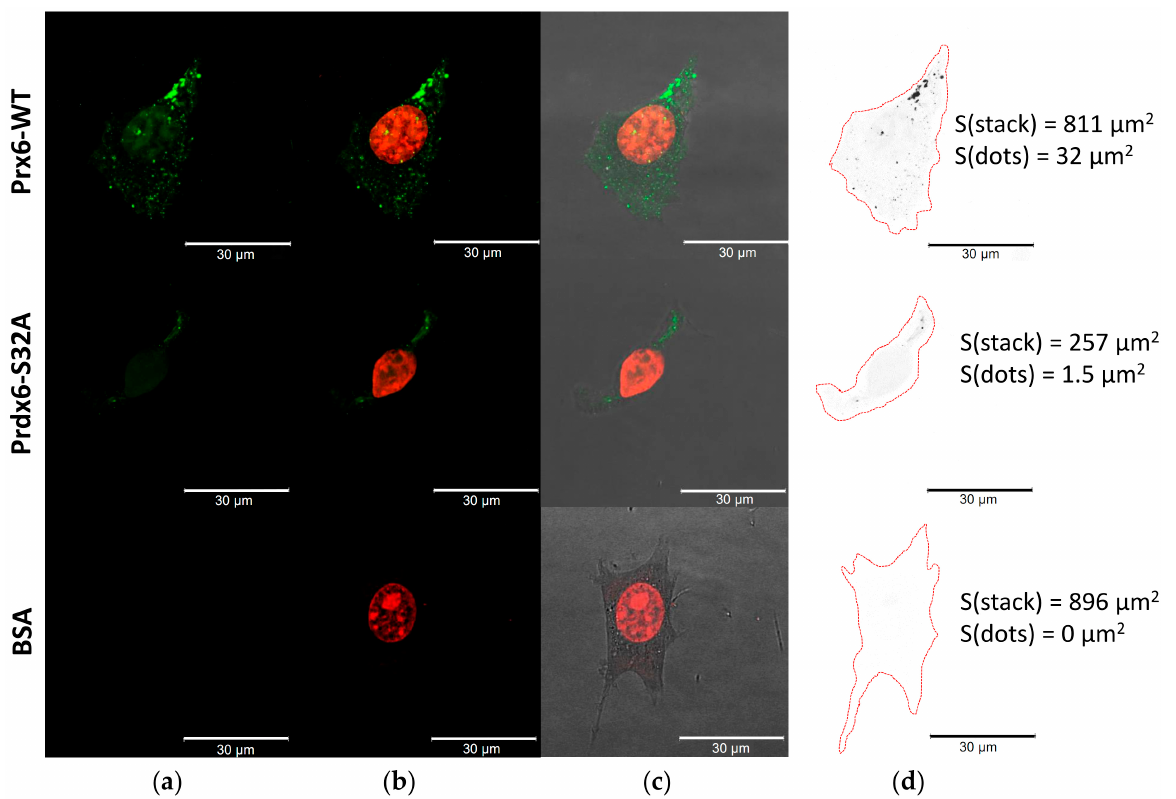
Figure 4. Penetration of exogenous Prdx6 (WT and S32A) into 3T3 cells. ( a ) FAM channel (green) corresponds to FITC–labeled proteins; ( b ) Texas Red channel (red) is aligned with the FAM channel and marks ethidium bromide-stained genomic DNA; ( c ) superimposition of FAM + Texas Red + phase contrast; ( d ) areas analyzed in ImageJ are marked, cell contours are shown in red, stack areas and areas with labeled proteins (dots) are shown at the right. Scale bars are 30 μ m. Table 2. Penetration of exogenous labeled Prdx6(WT and S32A) and BSA proteins into the cells.